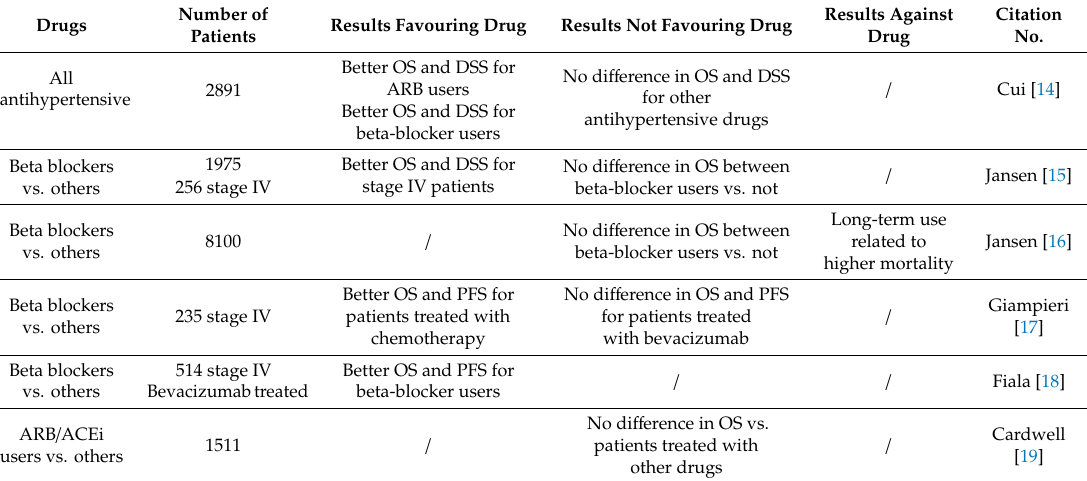
Table 1. Summary of studies for antihypertensive drugs as a prognostic